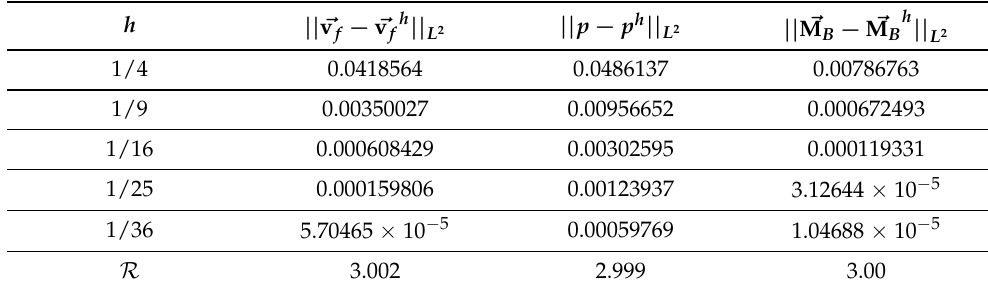
Table 2. The error estimate for MHD with standard FE P 2 − P 2 − P 1